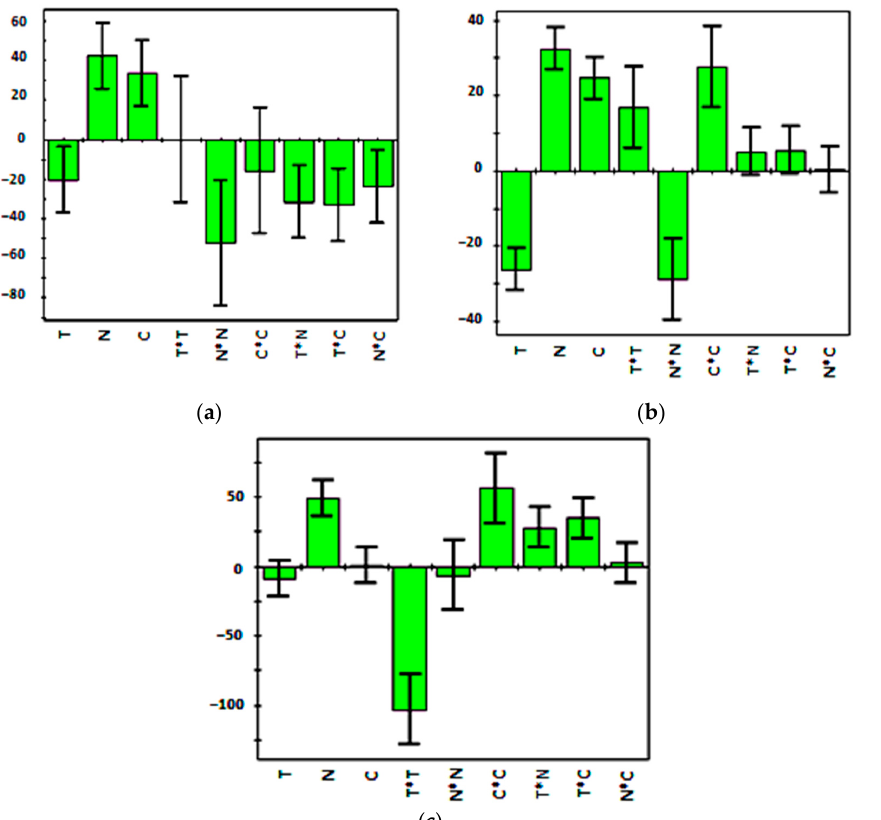
Figure 5. Coefficients of mathematical models plotted by MODDE. ( a )Total phenols; ( b )Total flavo- noids; ( c )Condensed tannins. flavonoids; ( c ) Condensed